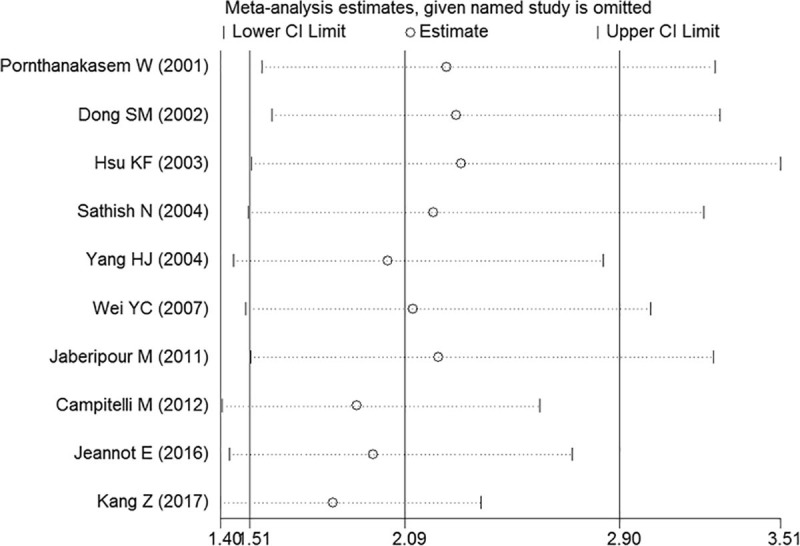
Sensitivity analysis of the overall pooled study.